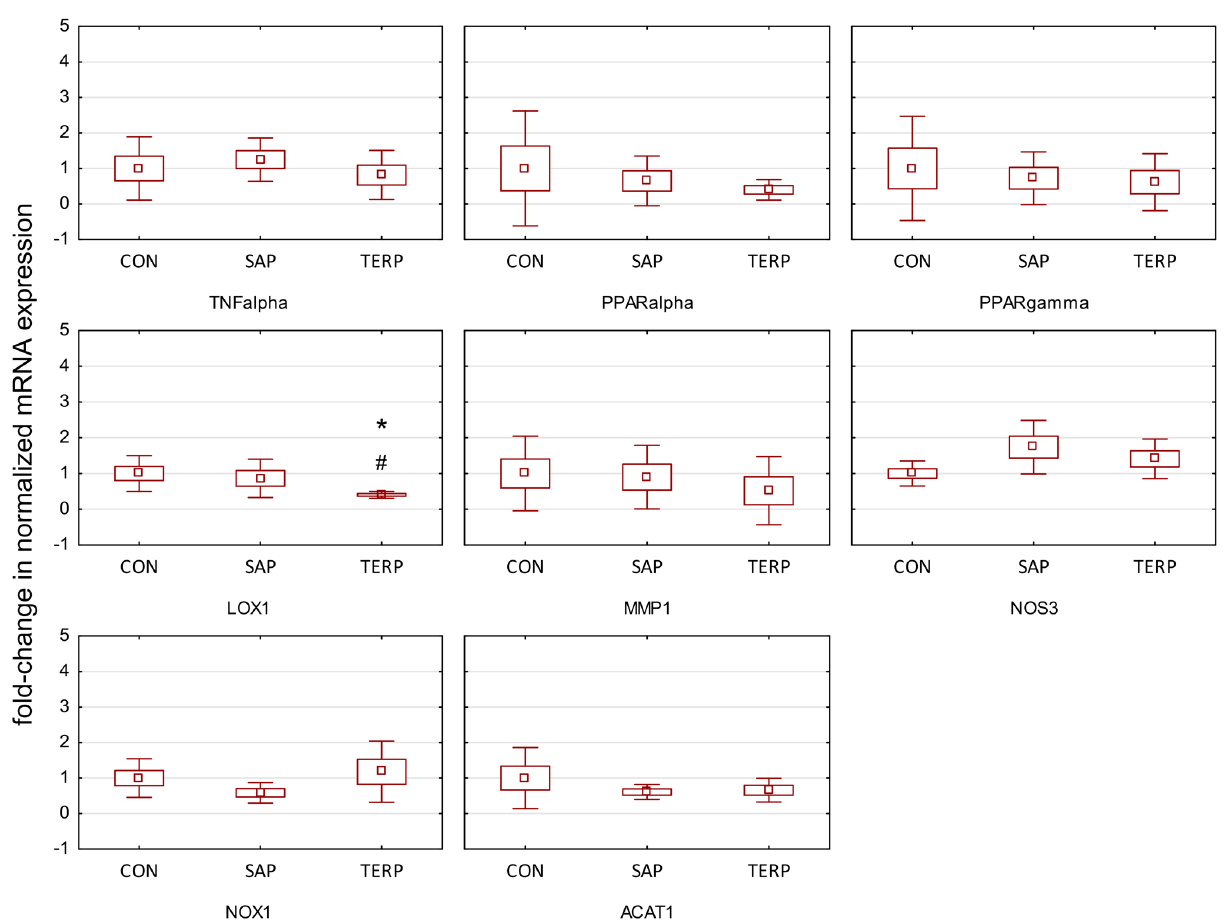
Figure 2. Expression of genes after treatment of saponin and terpenoid fraction in Zucker rat aorta. CON, control group; SAP, rats fed a standard diet with the addition of saponin fraction; TERP, rats fed a standard diet with the addition of terpenoid fraction. Values were normalized against Gapdh expression and presented as a fold-change in relation to gene expression in a control group. Specific comparisons: * p < 0.05 vs . CON; # p < 0.05 vs . SAP (ANOVA followed by the post hoc test). TNFα , tumor necrosis factor alpha; PPAR α , peroxisome proliferator- activated receptor alpha; PPARγ , pe- roxisome proliferator- activated receptor gamma; LOX1 , lectin- type oxidized LDL receptor; MMP1 ,